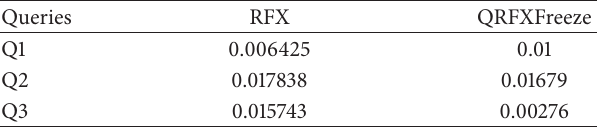
Table 4: Query execution times for nested queries. Figure 5: Storage size comparison (compression ratio) of QRFXFreeze with other queryable